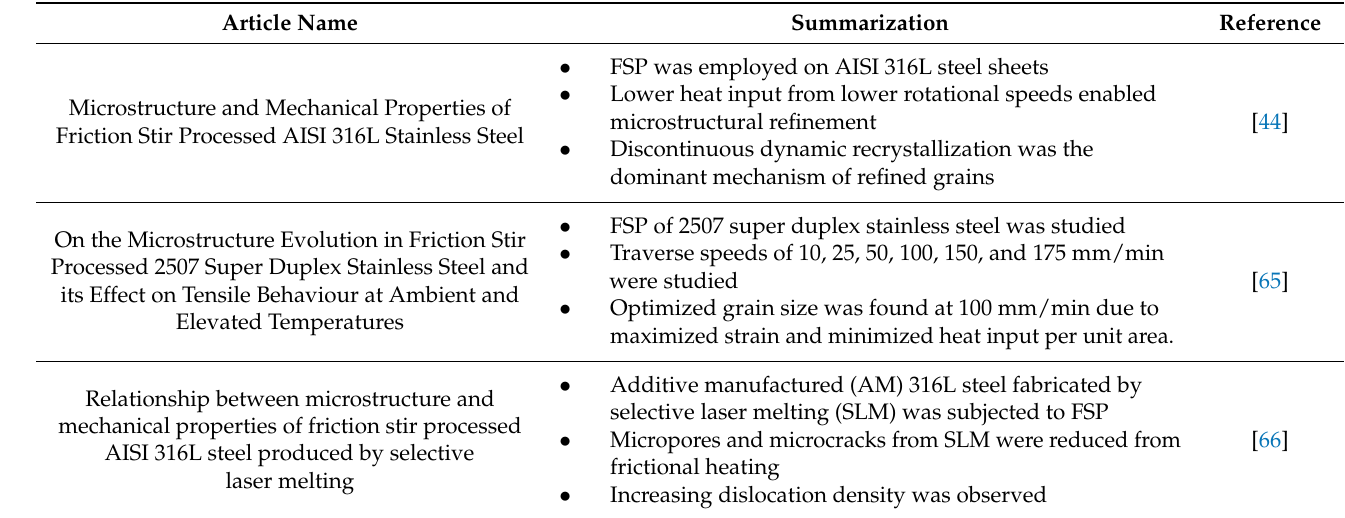
Table 1. Publications relating to the microstructural, mechanical, and tribological refinement of FSP steels. Article